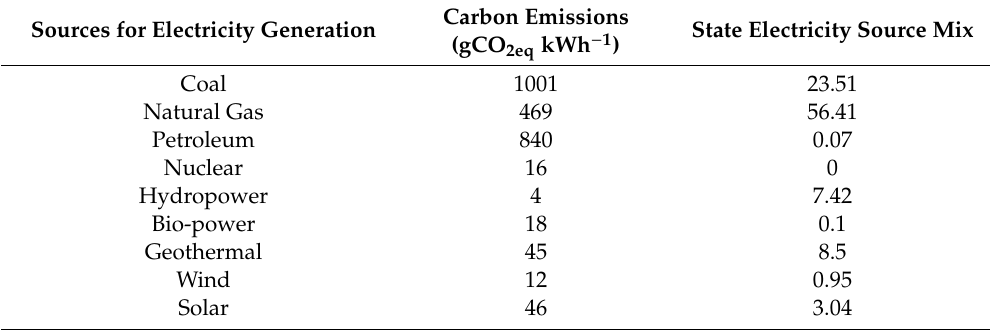
Table 2. Carbon emissions [76] and Nevada’s electricity source mix